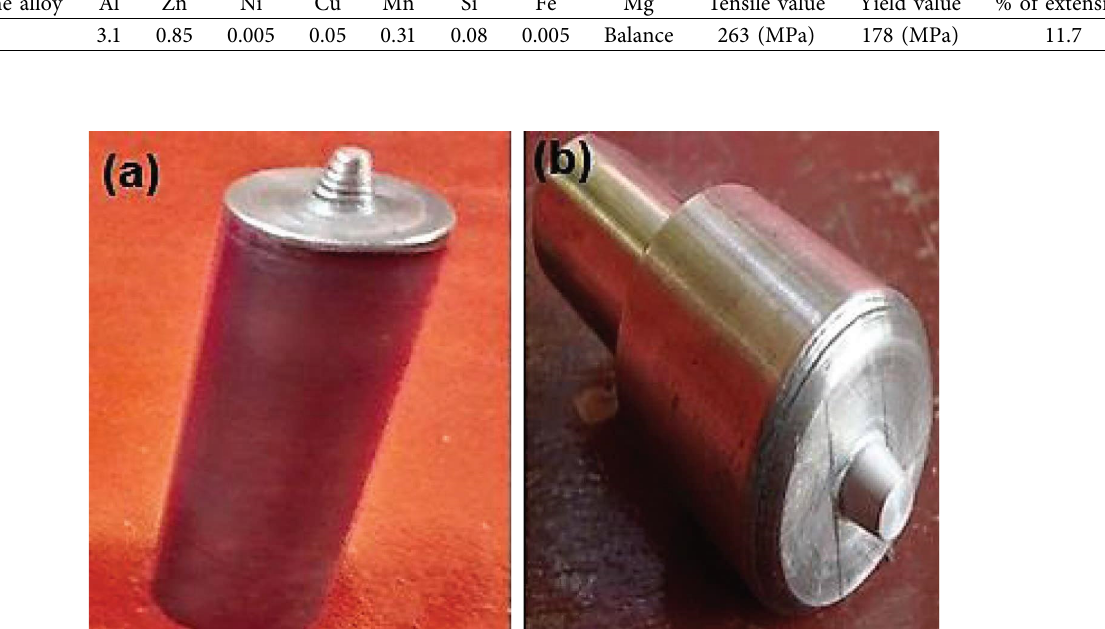
Figure 1: Picture of tool pins. (a) Tapered tool pin cylindrical shape with threads (TPT). (b) Tapered tool pin cylindrical shape without threads